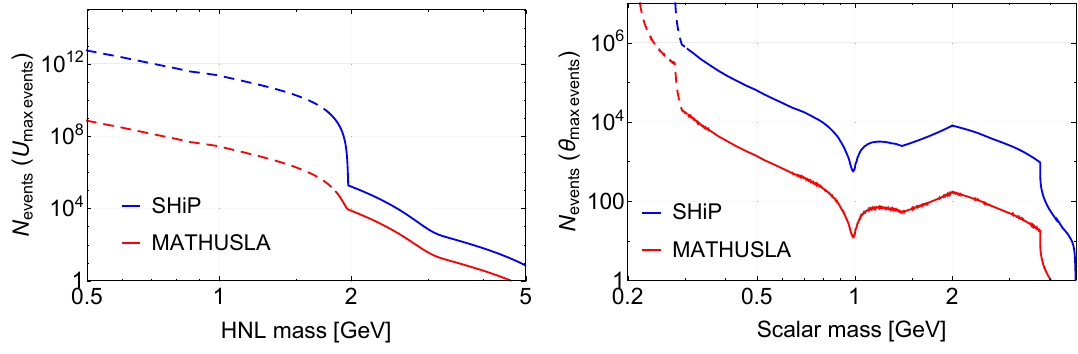
Figure 7 . The dependence of the number of events at SHiP and MATHUSLA evaluated at U 2 = for the HNLs mixing with ν (left) and for scalars (right). Dashed lines denote the values for θ 2 e max for which the sensitivity of SHiP and MATHUSLA intersects the domain that has been closed U 2 max by previous experiments (see, e.g.,